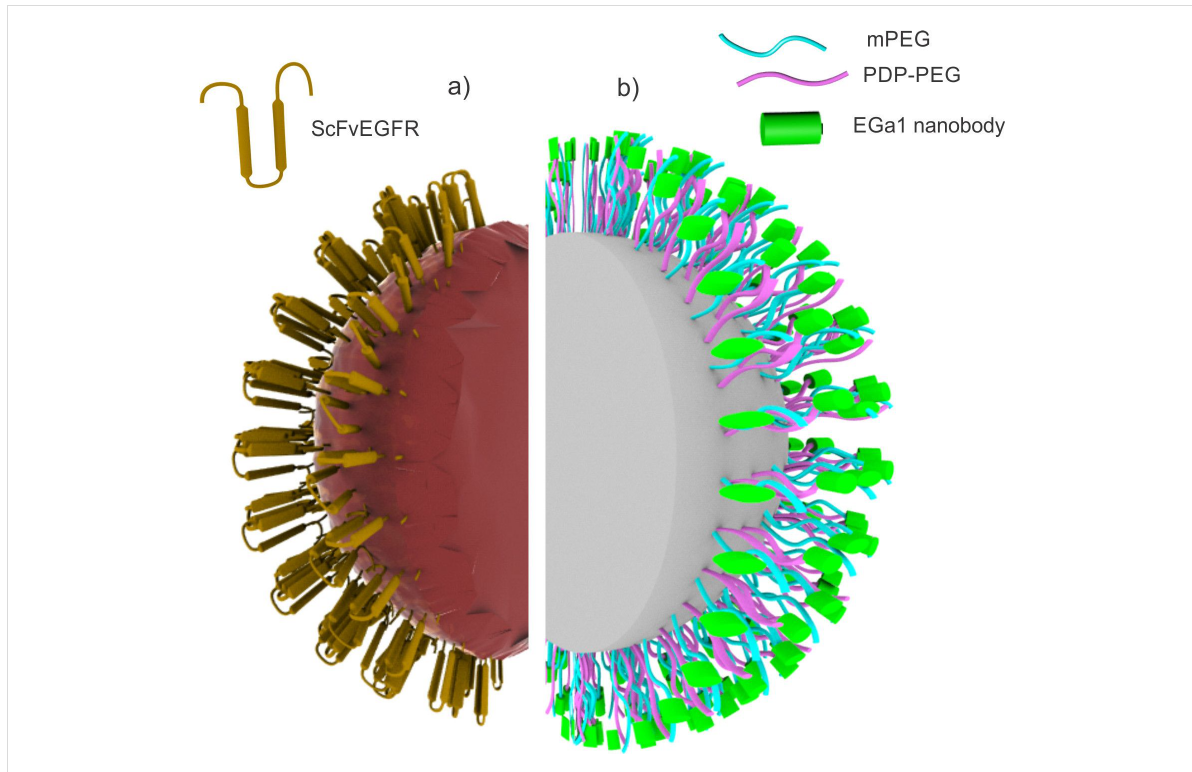
Figure 4: EGFR targeting strategies using “non-conventional” ligands. (a) Heparin nanoparticles with surface-oriented recombinant single-chain anti- body (ScFvEGFR) for efficiently targeting EGFR-positive NSCLC cells; adapted from [81]. (b) (mPEG/PDP-PEG)- b -p(HPMAm-Lacn) nanomicelles decorated with EGa1 nanobodies for selectively targeting EGFR-positive A431 and UM-SCC-14C cells; adapted from